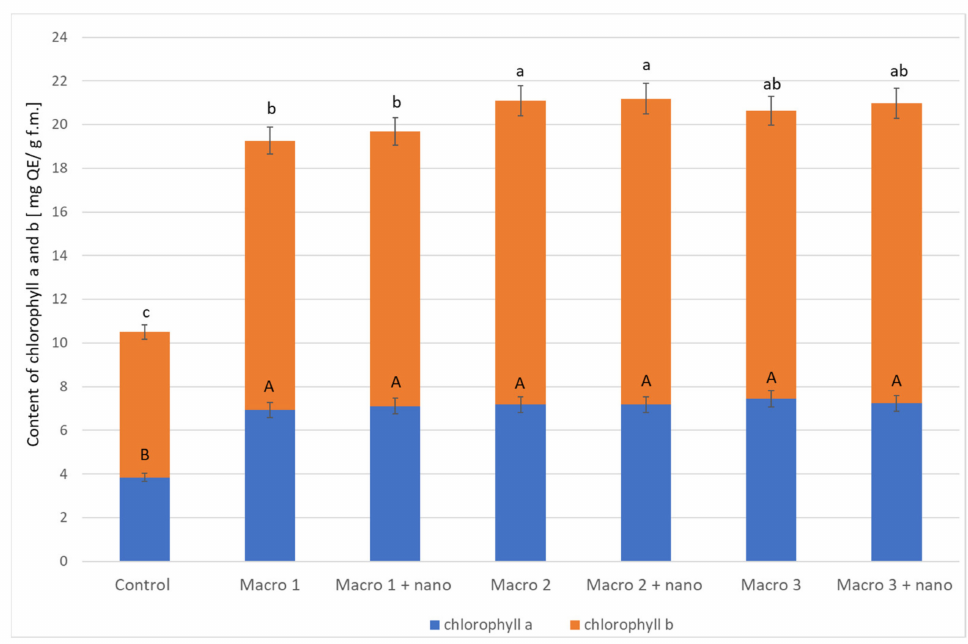
Figure 2. The content of chlorophyll a and chlorophyll b [mg g − 1 fresh weight.] in the shoots of plants grown in soil supplemented macronutrients or macronutrients and nanoparticles. Vertical bars represent the mean values (n = 5) ± standard deviations. Different letters indicate significant difference at p < 0.05 by LSD